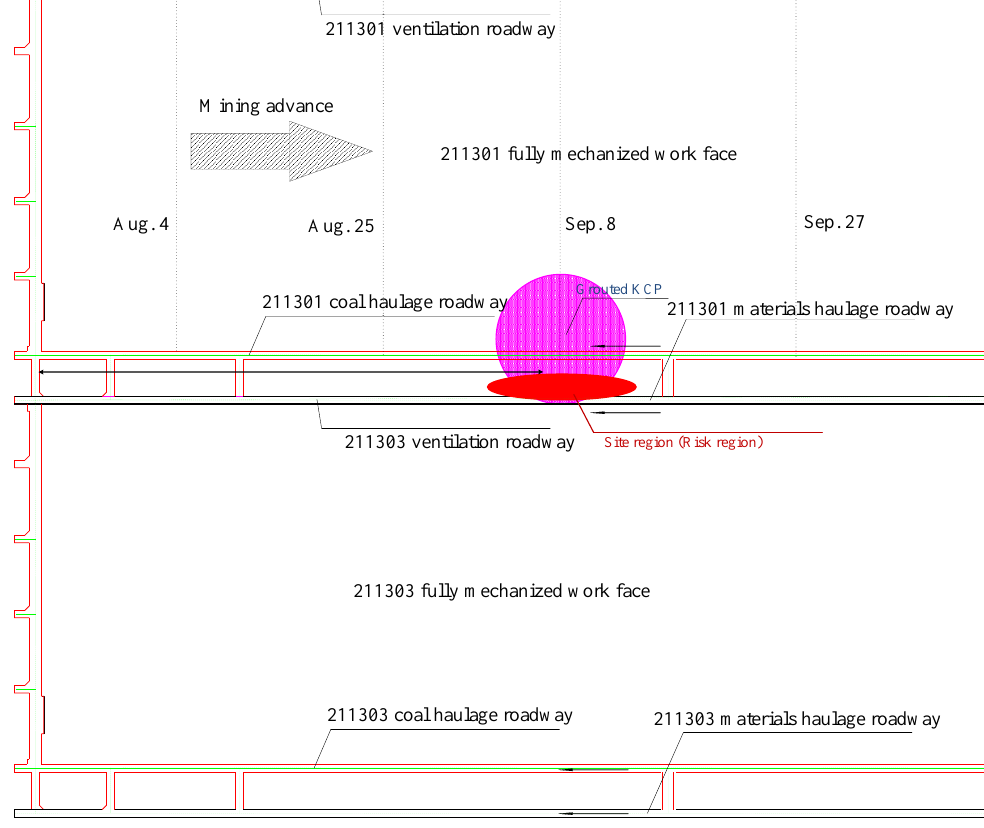
Figure 5. Layout of site observation.